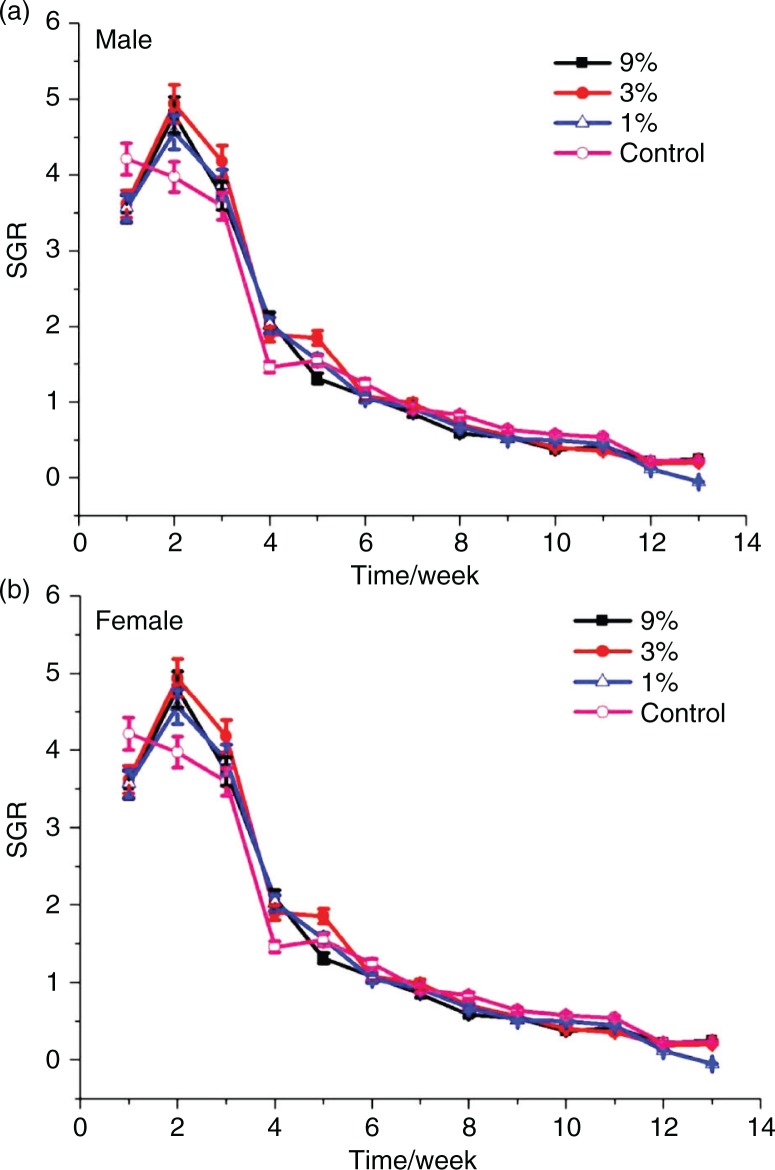
Specific growth rates (SGR) for male and female Sprague-Dawley rats treated with MRPB for 13 weeks. (a) SGR for male SD rats during 13 weeks; (b) SGR for female SD rats during the 13-week study. The SGR for weight was calculated as SGR (%)=(lnw2-lnw1)×100/feeding days, where w1 and w2 are start and final weights, respectively, and ln is the natural logarithm. MRPB, Maillard reaction products of chicken bone hydrolysate; 9, 3, and 1%, and control represents 9, 3, 1, and 0% of MRPB in diet for rats.